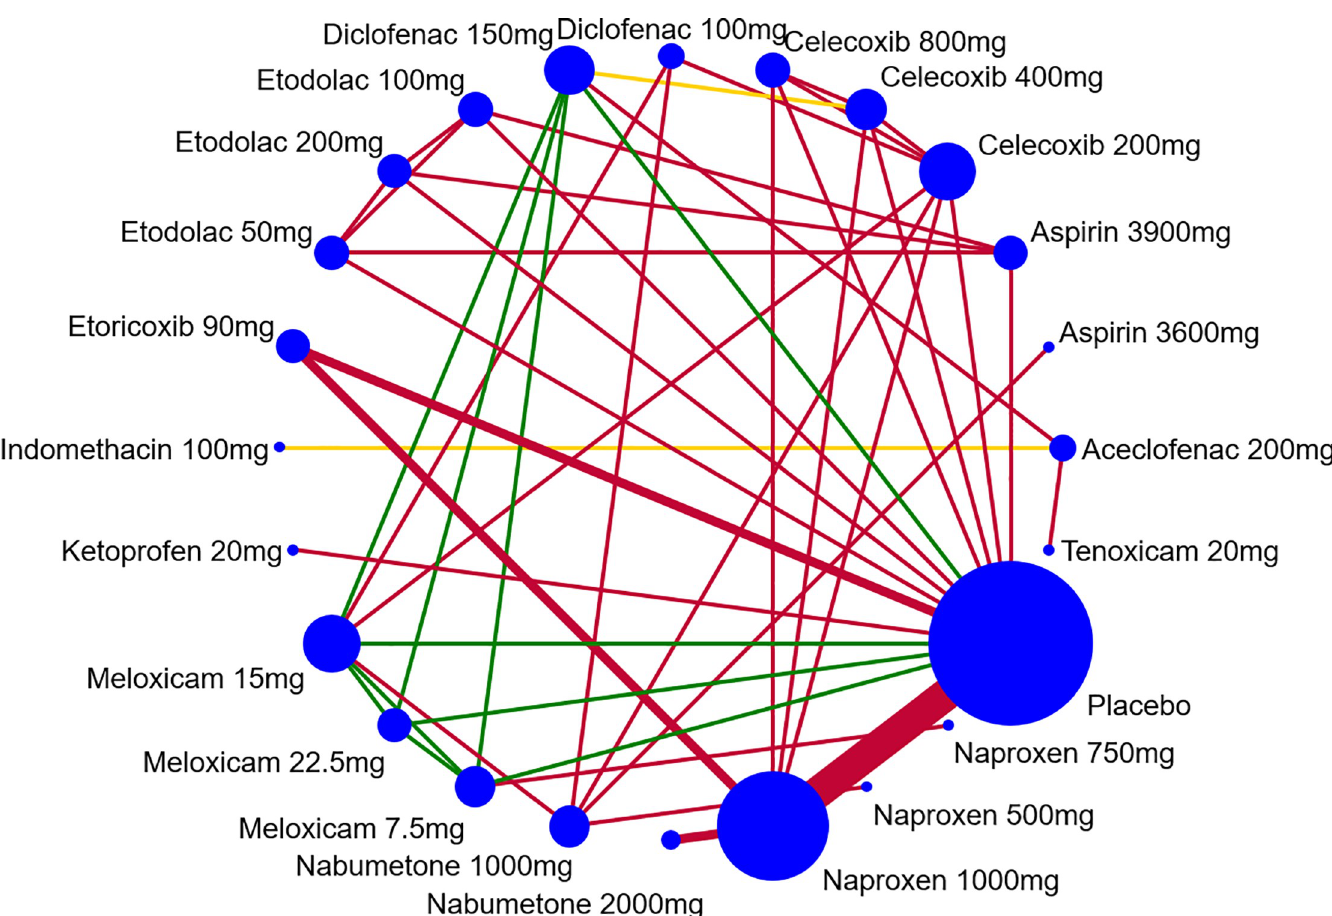
Fig 5. Evidence structure of eligible comparisons for network meta-analysis: Adverse events. Lines connect the interventions that have been studied in head-to-head (direct) comparisons in the eligible randomized controlled trials. The width of the lines represents the cumulative number of randomized controlled trials for each pairwise comparison and the size of every node is proportional to the number of randomized participants (sample